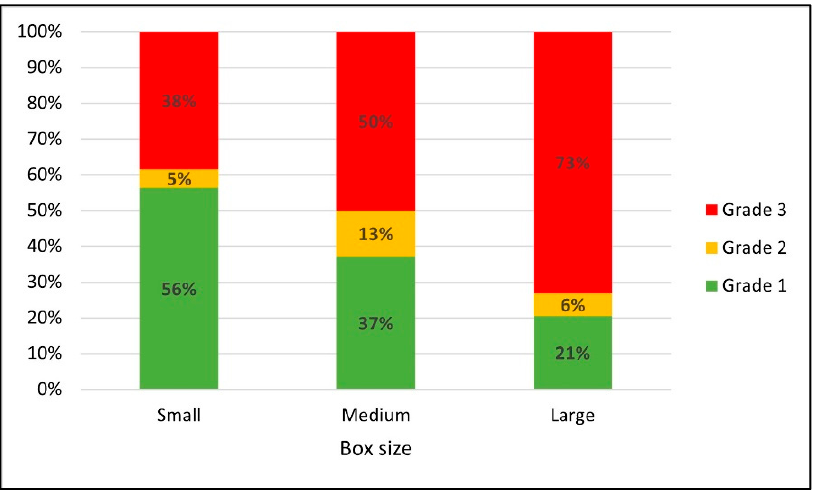
Figure 8. Changes in the proportions of the different grade scenarios in response to the box sizes.